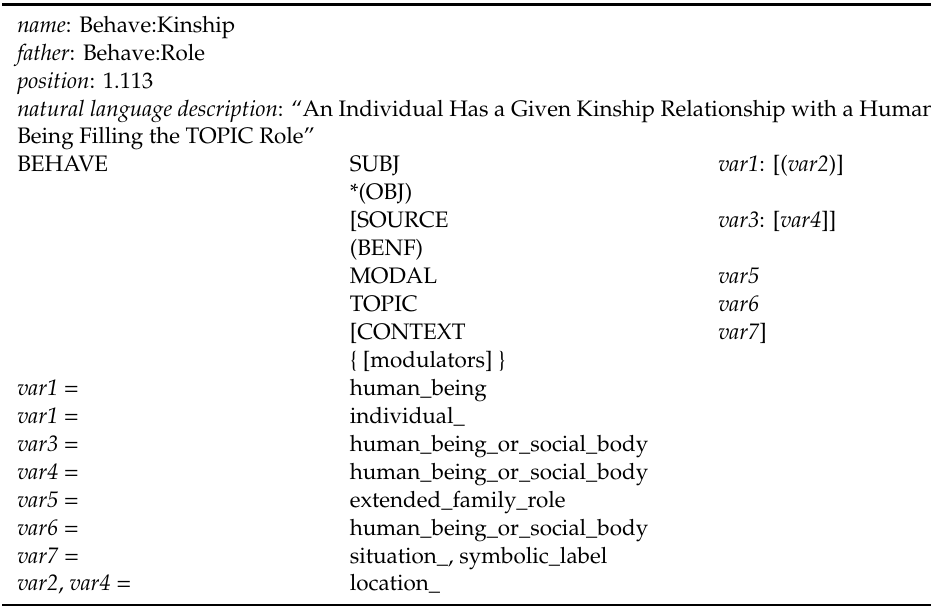
Table 2. The Behave:Kinship